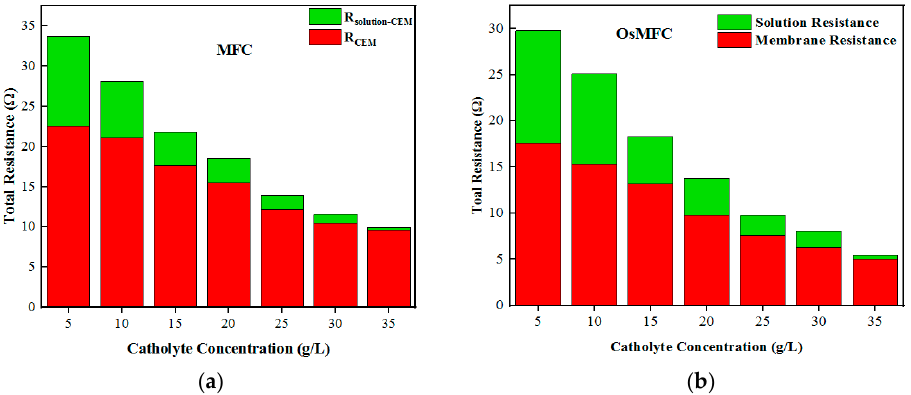
Figure 7. Changes in membrane impedance and solution impedance with solution concentration.